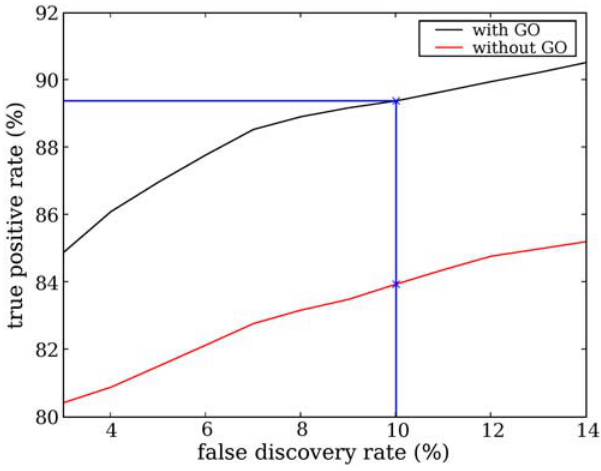
Figure 4. The true positive rate vs. false discovery rate of two classifiers using both the RBF and TPPK kernels. The false discovery rate (FDR) was estimated assuming a negative-to-positive ratio of 600:1. The black line indicates the performance of the classifier using all features, while the red line indicates the performance of the classifier without using the features based on GO term annotations. The x -axis begins at an FDR of 3% because very small FDRs cannot be estimated accurately for this dataset.